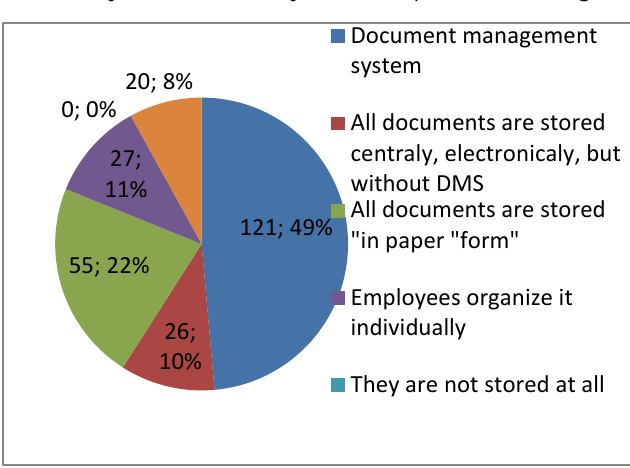
Fig. 7. The way of storage of process